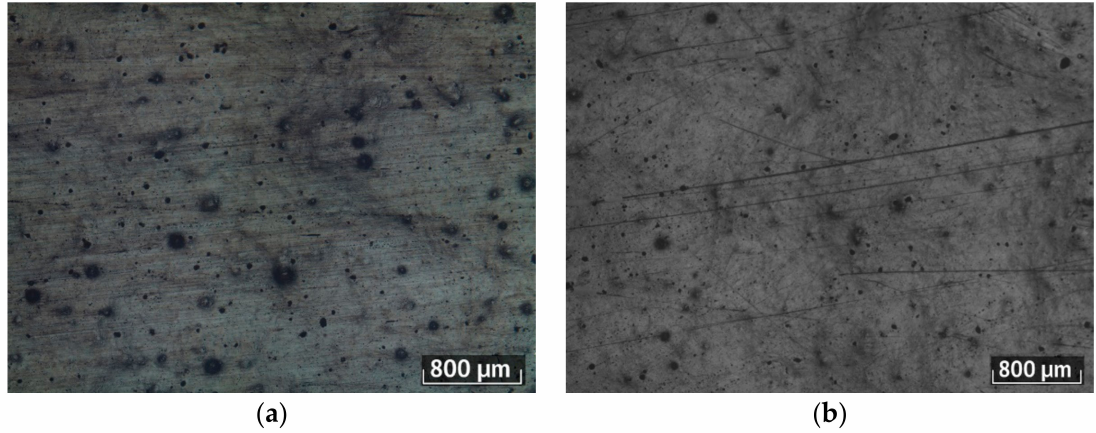
Figure 11. Microstructure of coating after test: ( a ) one decompression cycle; ( b ) two decompression